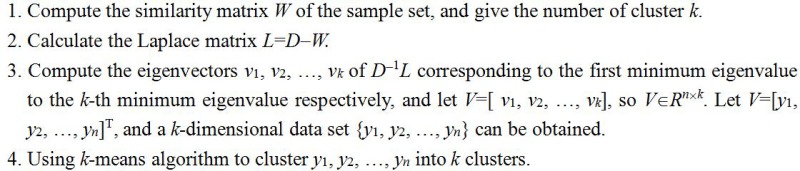
The NCSC algorithm.